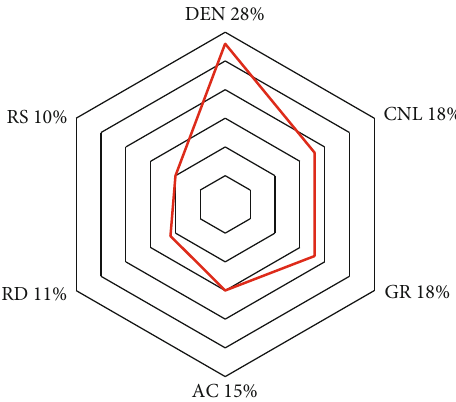
Figure 5: Analysis of conventional logging and rock granularity median sensitivity parameters of S